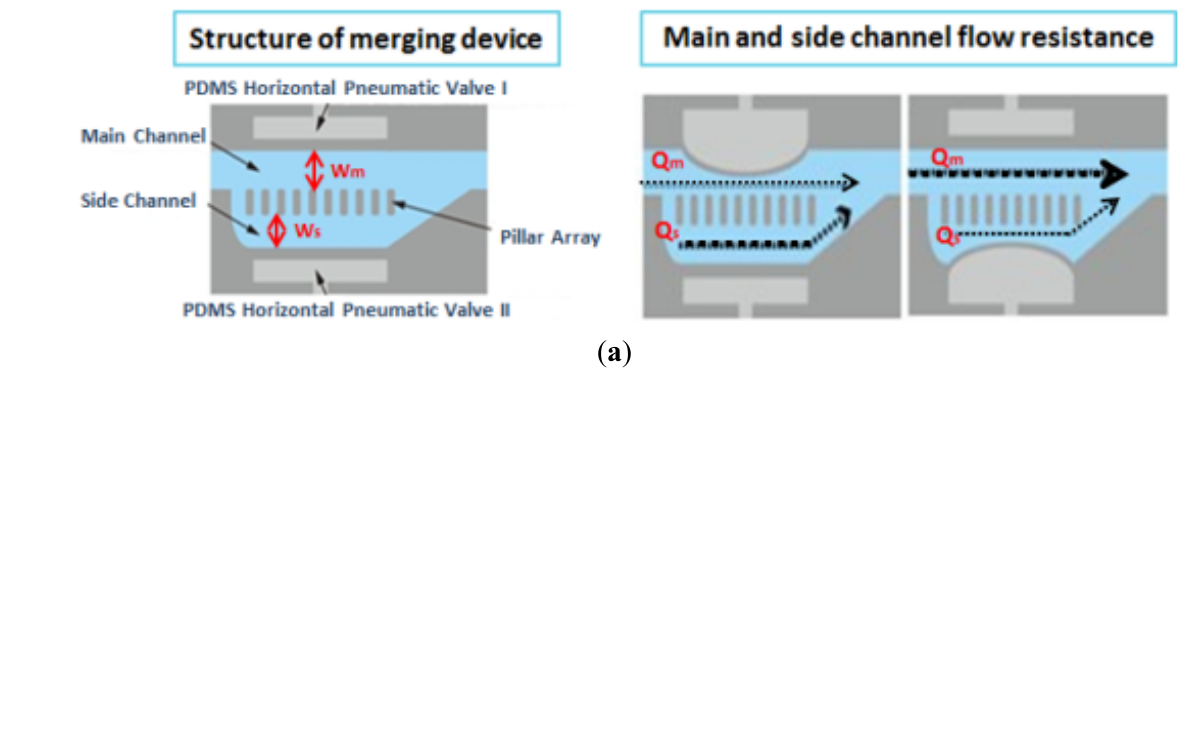
Figure 1. Working principal of the merging device (a) Schematics of the structure and the main and side channel flow resistance (b) equivalent band model of the merging device (c) Two and three droplets merging with the different combinations of Valve I and Valve